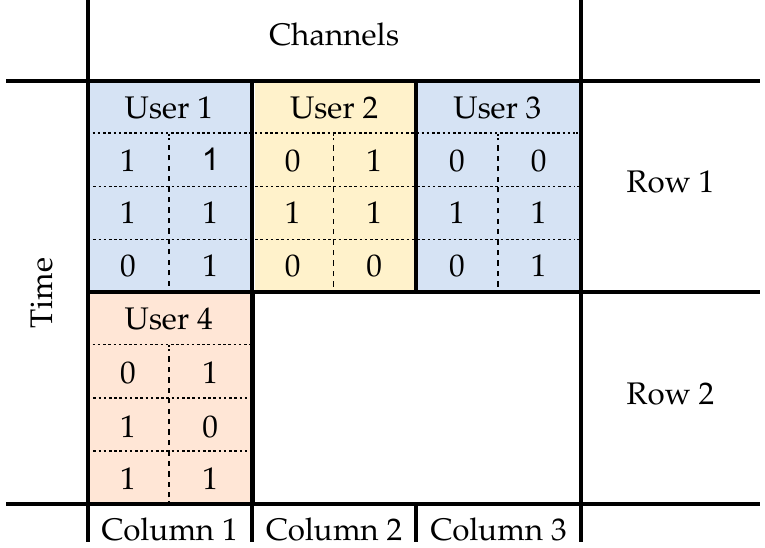
Figure 10. Training for four secondary users, with 67% collaboration and continuous selection.